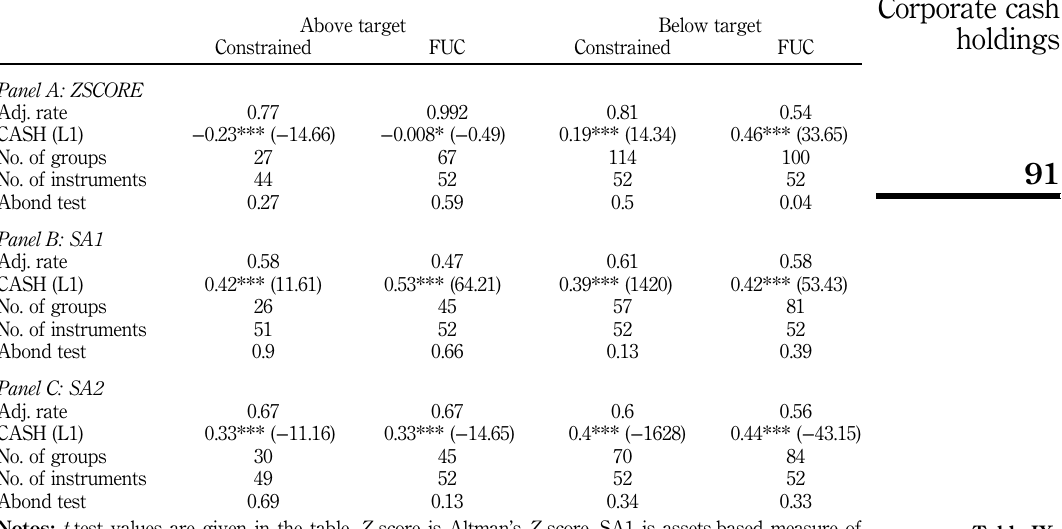
Table IX. Regression results for asymmetric speed and